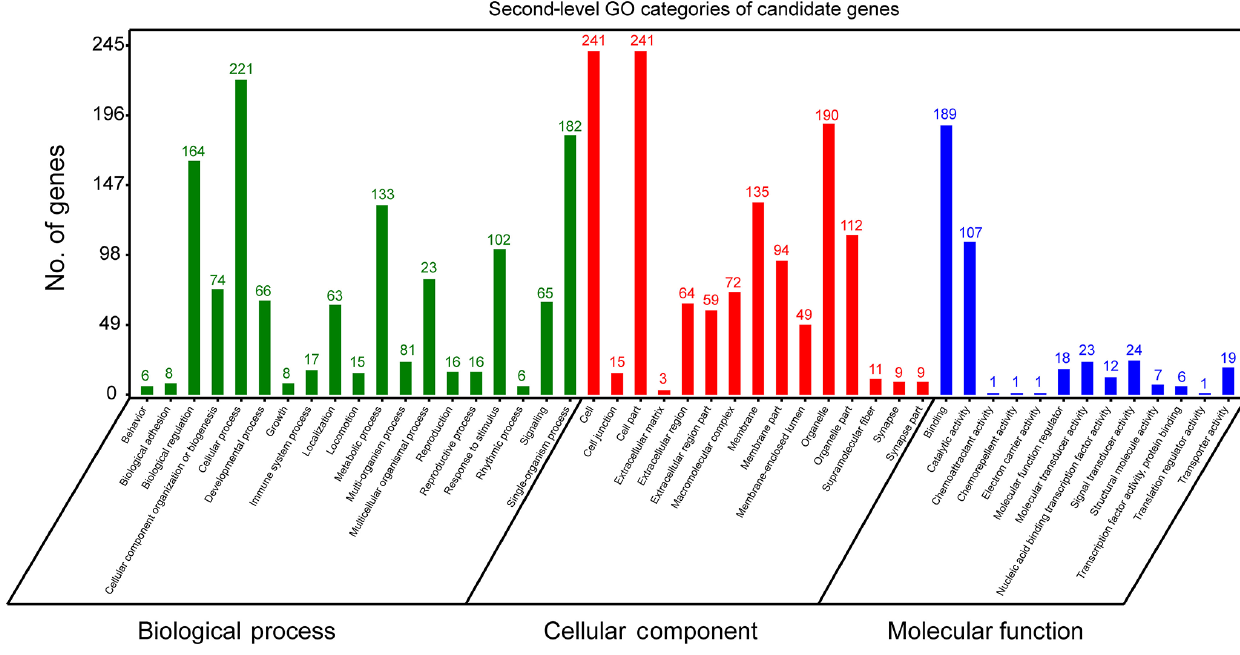
Figure 3. Second-level GO categories of candidate